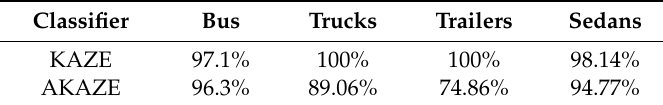
Table 2. BoF classifiers classification accuracy results.